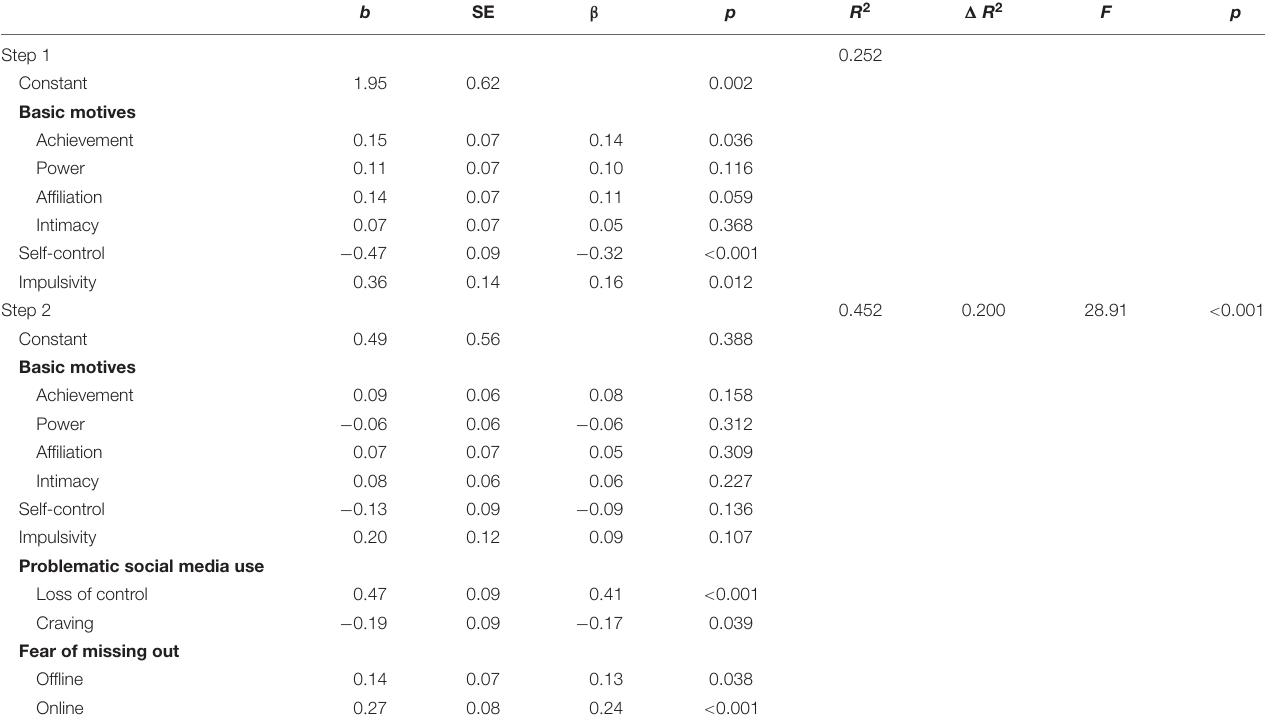
TABLE 8 | Hierarchical regression examining the effect of traits on task-related distraction.